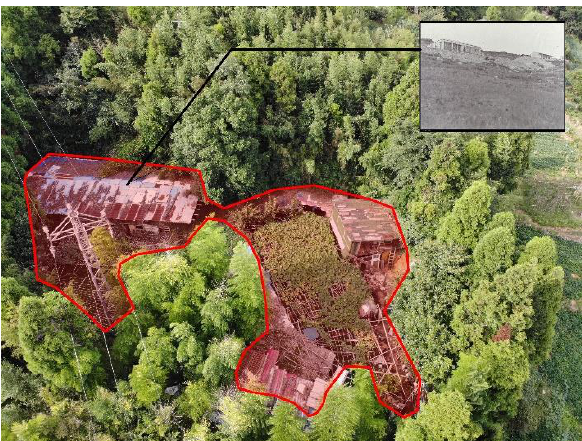
Figure 7 With the help of drone, the team found the site of No.370 cottage in Liangcuo, which was belonged to Dr. T. Rennie and the Imperial Maritime Customs of Fuzhou. The site is surrounded by trees, mostly are Cryptomeria, which can